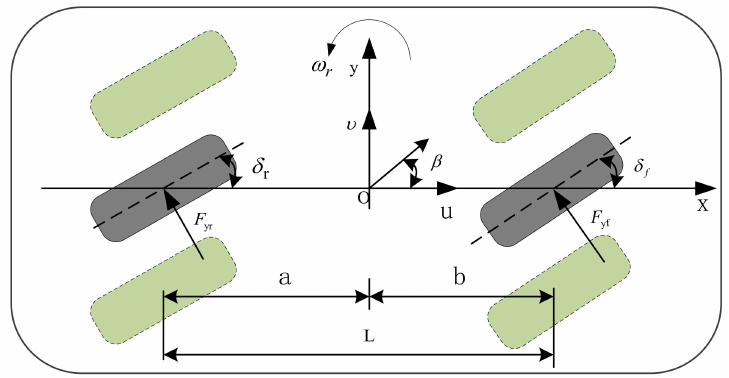
Figure 1. Single-track vehicle